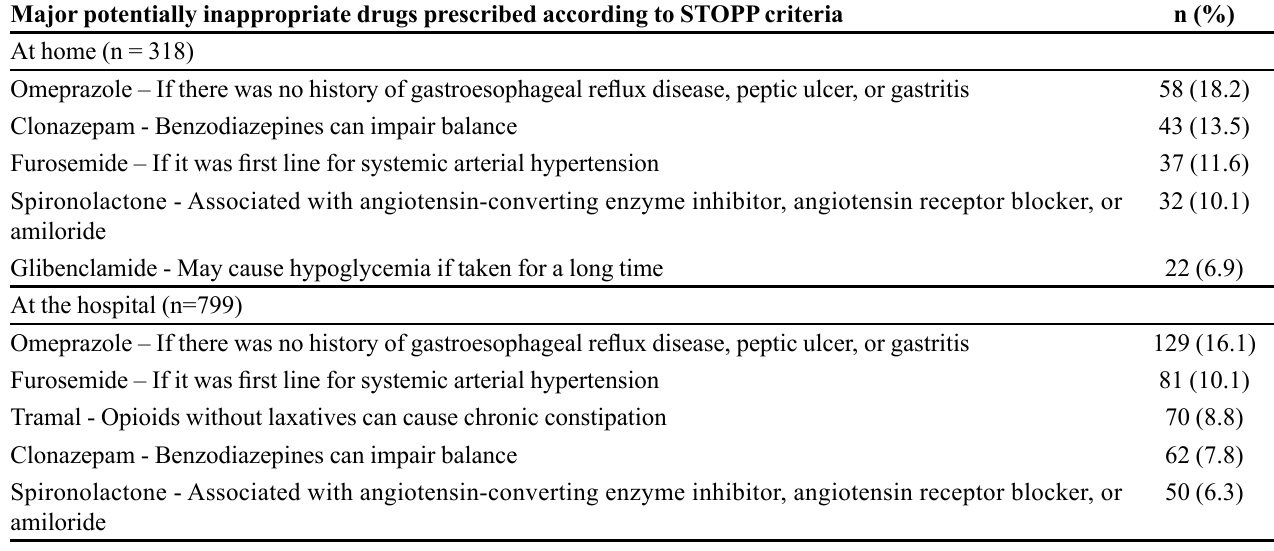
TABLE IV - Frequency of the five most commonly prescribed medications taken at home and at the hospital by the surveyed